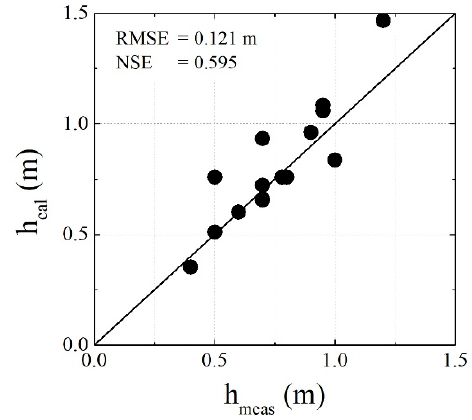
Figure 9. Comparison of modeled versus measured inundation depths.